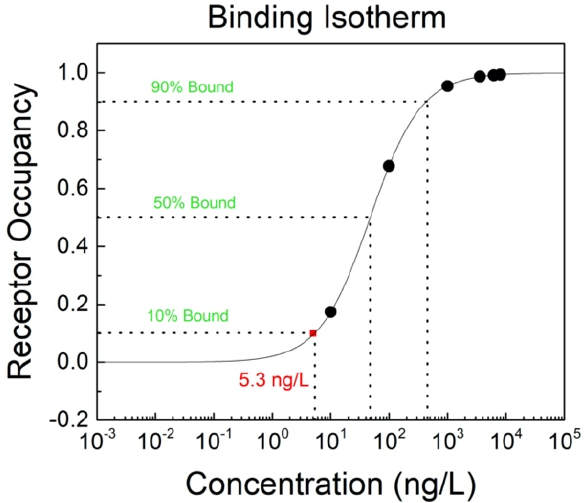
Figure 5. Binding isotherm for the antibody (receptor) occupancy with ferritin antigen on the GFET